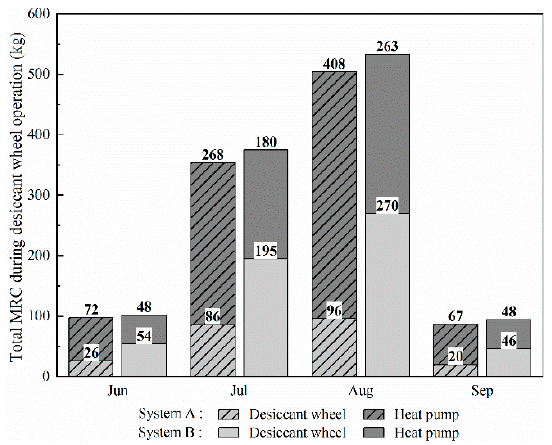
Figure 12. MRC during desiccant wheel operation.